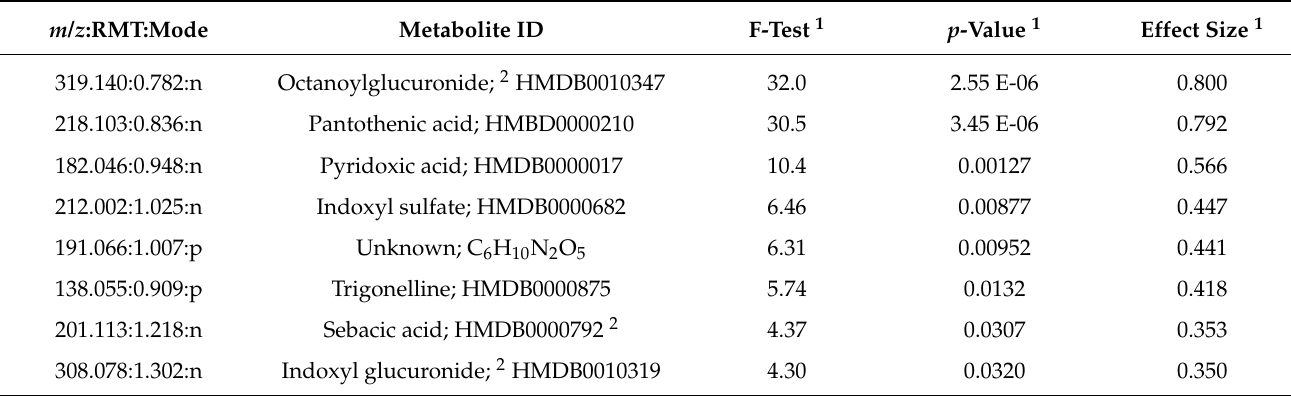
1 Statistical significance ( p < 0.05) based on interaction term (treatment × time) for log -transformed urine metabolome data with effect size calculated using partial eta 2 . 2 Putative identification (level 3) of unknown metabolites based on accurate mass, MS/MS, and mobility